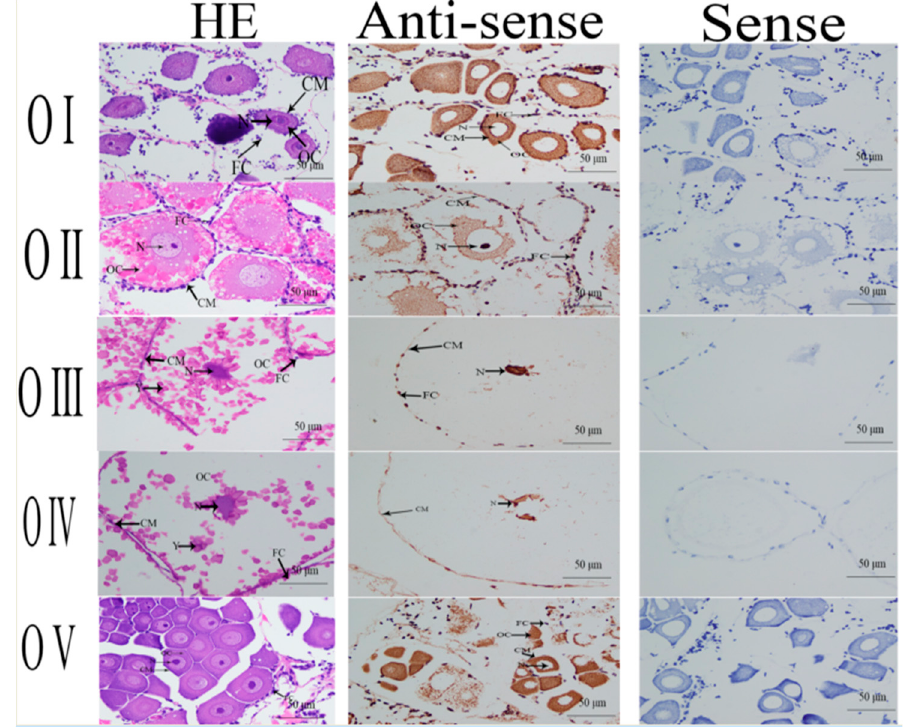
Figure 6. Location of the GEM gene was detected in ovary I to ovary V of M . nipponense by using in situ hybridization. OC: oocyte; N: nucleus; CM: cytoplasmic membrane; Y: yolk granule; FC: follicle cell. Scale bars = 50 μ m.